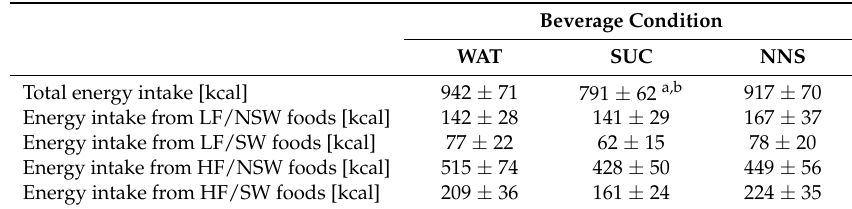
Table 2. Spontaneous food intake at the ad libitum